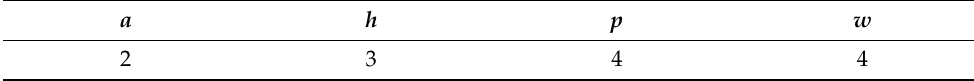
Table 3. Geometric parameters of the H-shaped corrugated SWTL (unit: mm). a